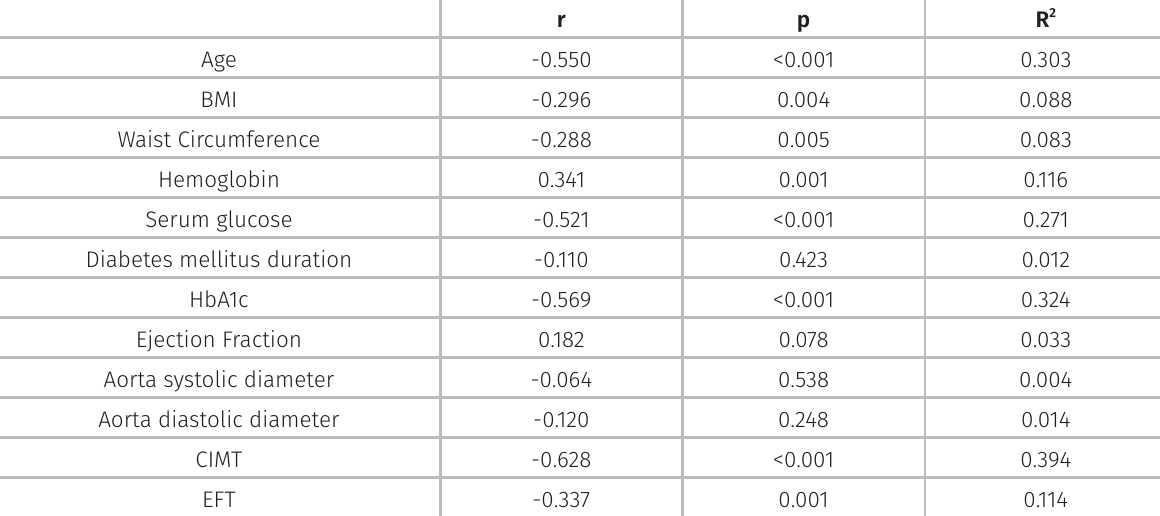
BMI, Body mass index; HbA1c, Glycolized hemoglobin; CIMT, carotid intima-media thickness; EFT, Epicardial fat thickness. Pearson test was used to analyze the relationship between AVP and study variables where appropriate. Correlation coefficient (r). p<0.05 was considered statistically